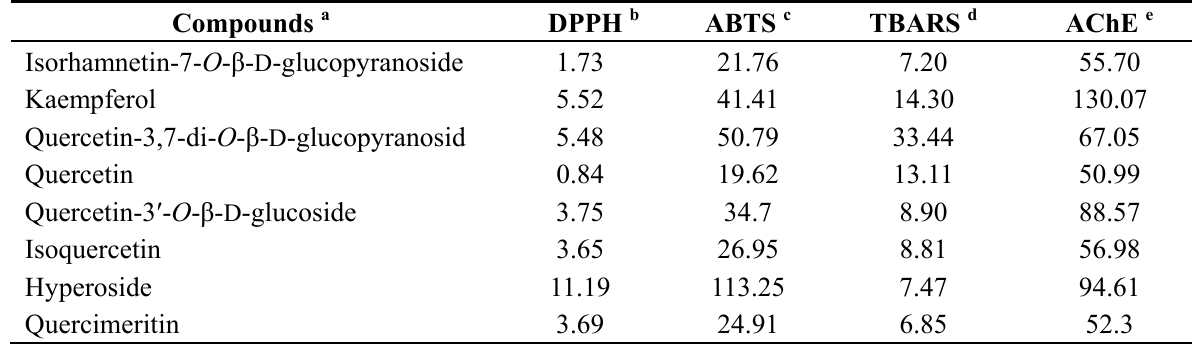
Table 2. Amounts of compound ( μ M) needed to inhibit acetylcholinesterase and antioxidant activities by 50%. Compounds a DPPH b ABTS c TBARS d AChE e Isorhamnetin-7- O - β - D -glucopyranoside 1.73 21.76 7.20 55.70 Kaempferol 5.52 41.41 14.30 130.07 Quercetin-3,7-di- O - β - D -glucopyranosid 5.48 50.79 33.44 67.05 Quercetin 0.84 19.62 50.99 Quercetin-3 ′ - O - β - D -glucoside 3.75 Isoquercetin 56.98 Hyperoside 11.19 113.25 7.47 94.61 Quercimeritin 3.69 24.91 6.85 52.3 a Mean values of three replicates are given. Mean ± SD, n = 3; b Compared to Vit C (IC = 15.0 μ M), IC 50 50